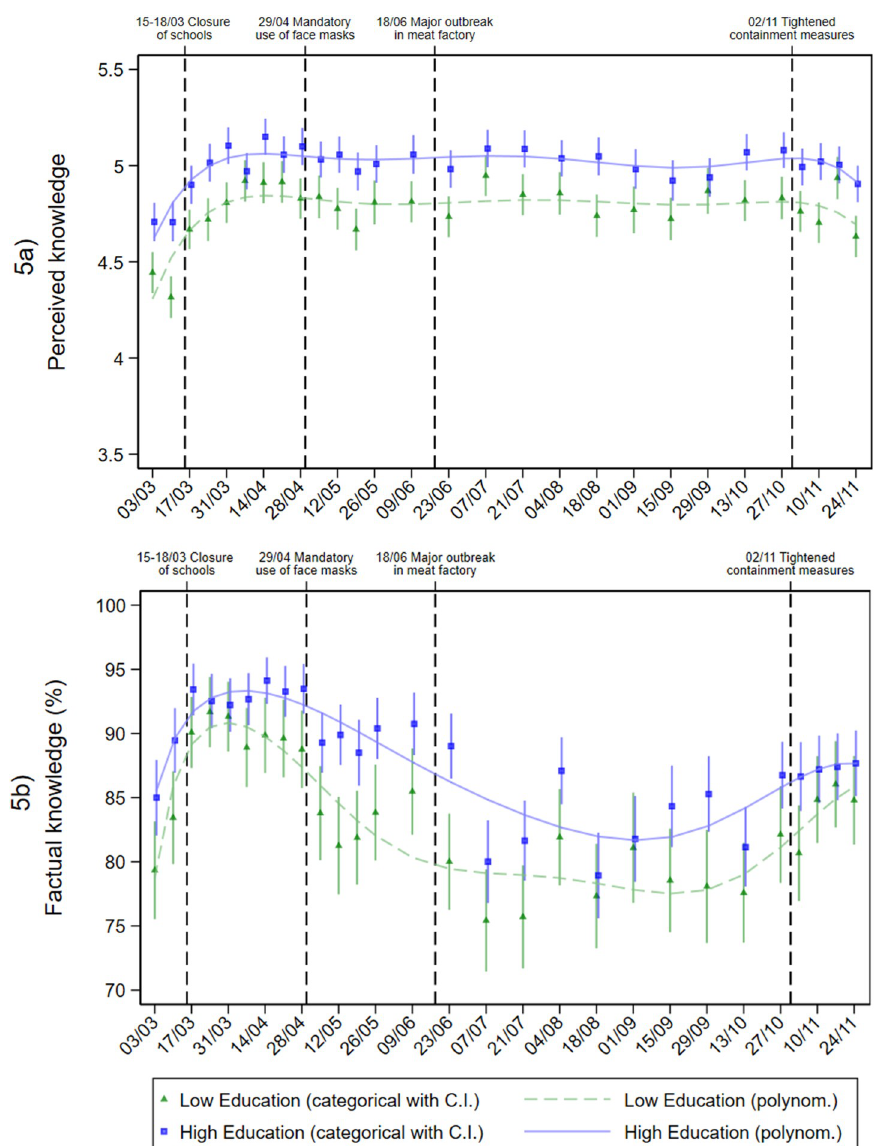
Fig 5. Perceived and factual knowledge in individuals with different education levels during the pandemic. Adjusted predictions from linear regression (perceived knowledge) and logistic regression (factual knowledge) with interaction between education level and calendar week (categorial and metric), adjusted for age group, gender, repeat respondent, community size, and federal state.